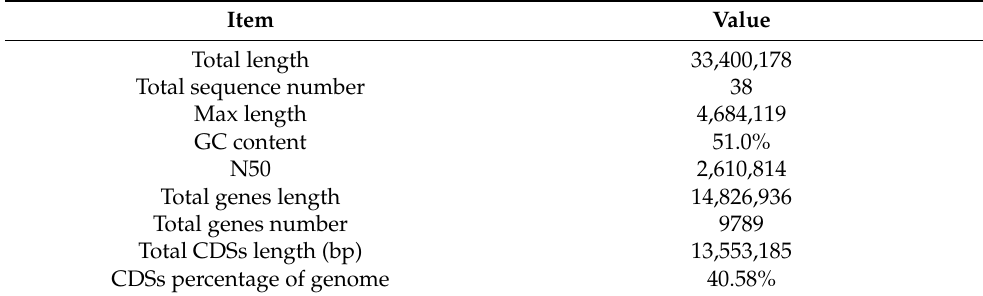
Table 1. General genomic features of strain SPS-2.